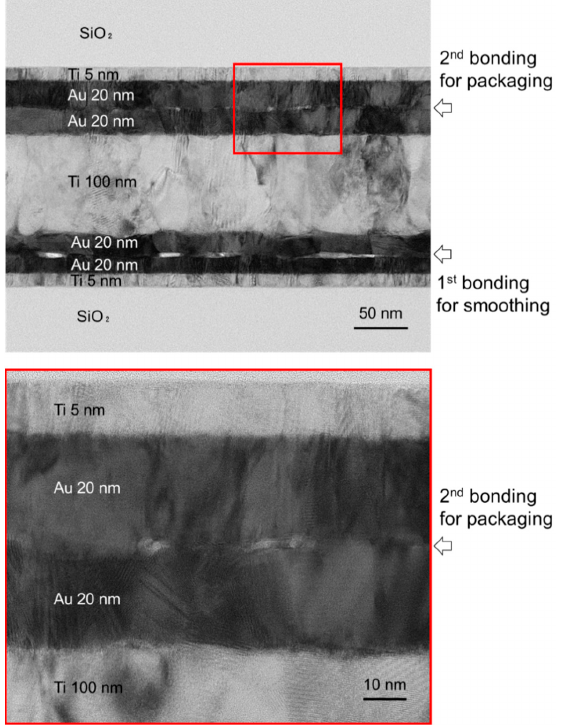
Figure 11. TEM image of the bonding interface. Although nanovoids were observed at the bonding interface for packaging, they did not tend to connect with others.